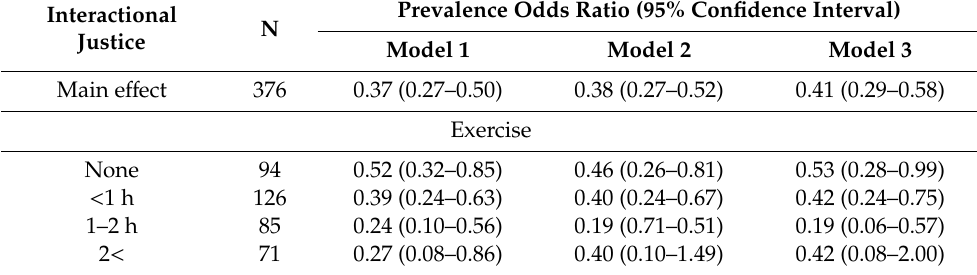
Table 4. Association of interactional justice with psychological well-being by regular exercise among Korean